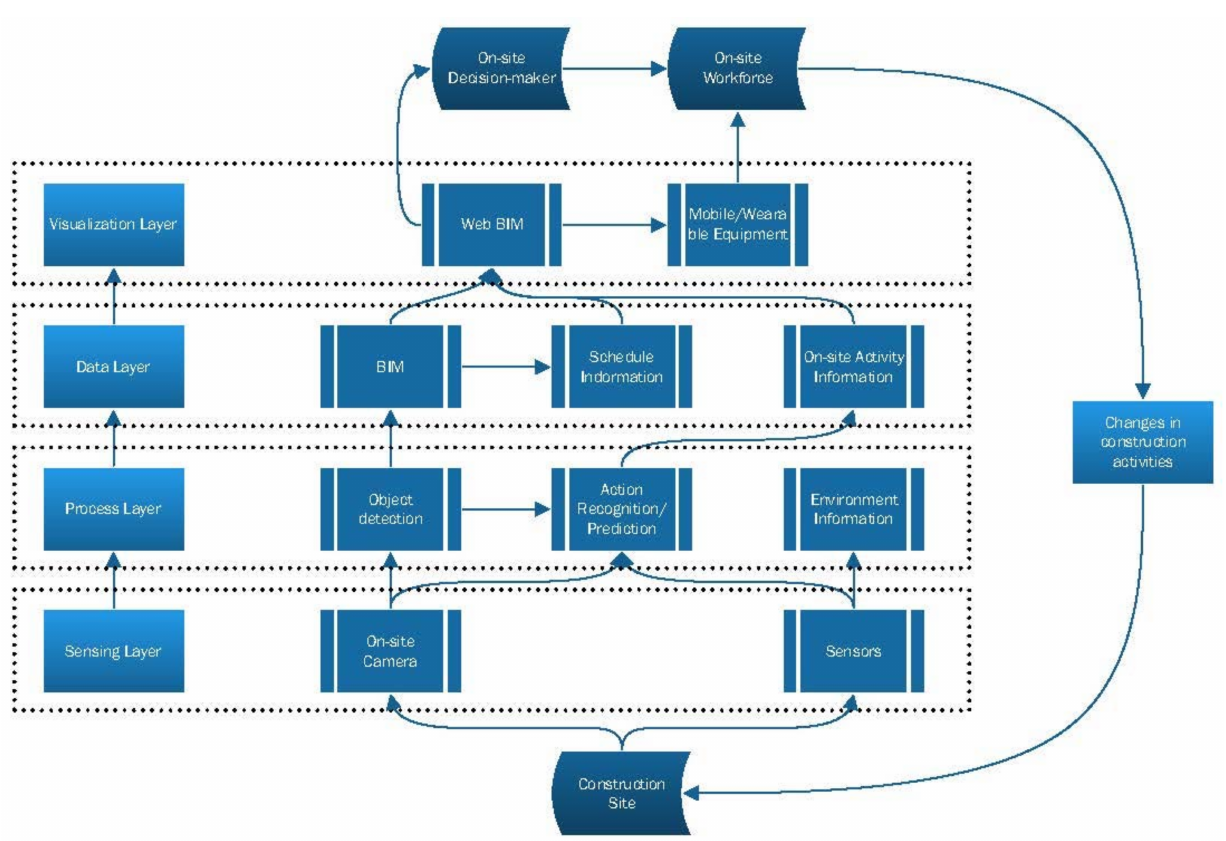
Figure 9. Overall framework of the construction process CPS.